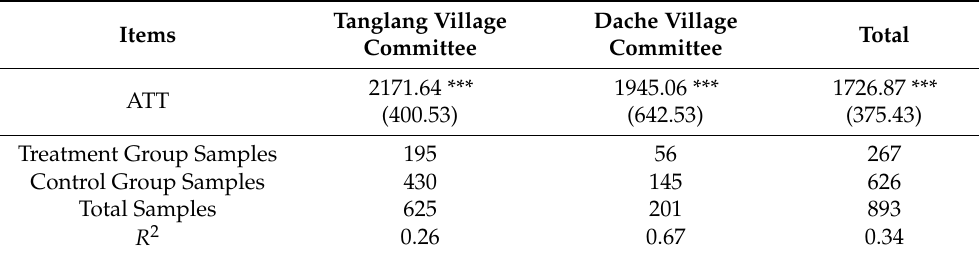
Table 10. Average treatment effect on the treated (ATT) estimation results obtained using the PSM- DID Model.